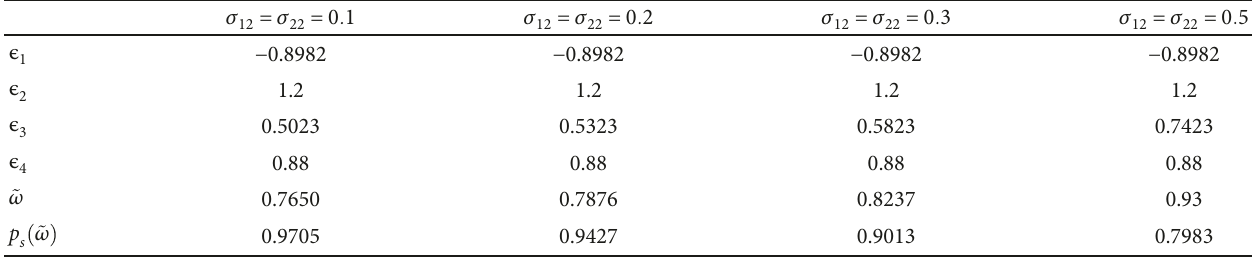
Table 1: Probabilities and occurrence positions of stochastic Hopf bifurcation of system (26) with σ of σ 12 and σ 22 .